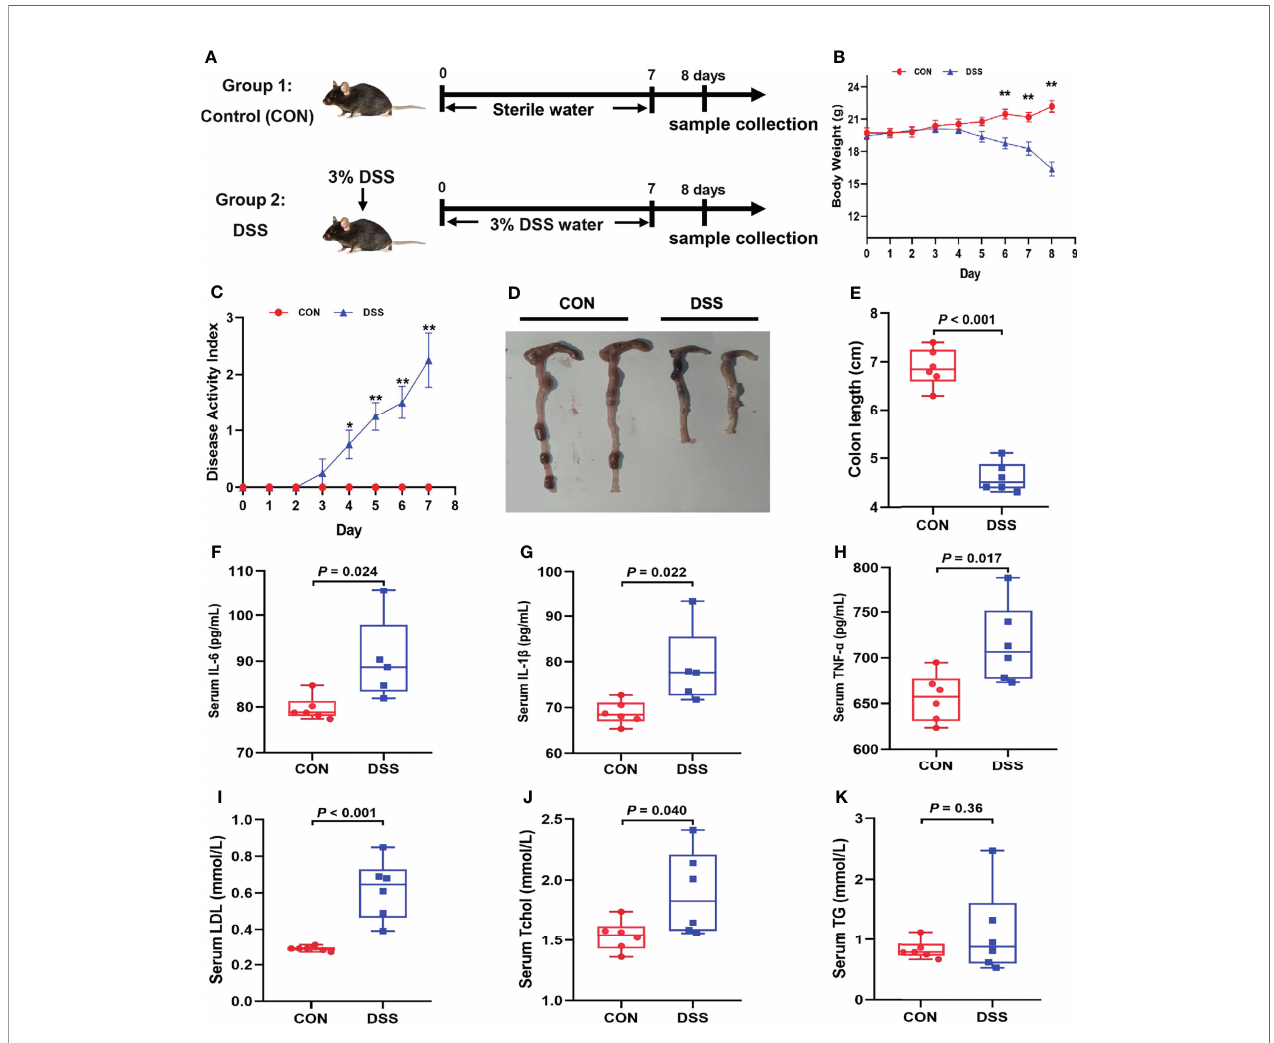
FIGURE 1 | DSS-induced acute colitis, systemic in fl ammatory response and lipid metabolism disorders in mice. (A) Schedule of the experiment treatment; (B) Body weight loss; (C) Disease activity index score; (D) Morphological observations of colon; (E) Colon length; (F – H) The concentrations of IL-6, IL-1 b and TNF- a in serum; (I – K) the content of LDL, Tchol and TG in serum. Data were expressed as means ± SEM (n = 5-6/group). * P < 0.05, ** P <